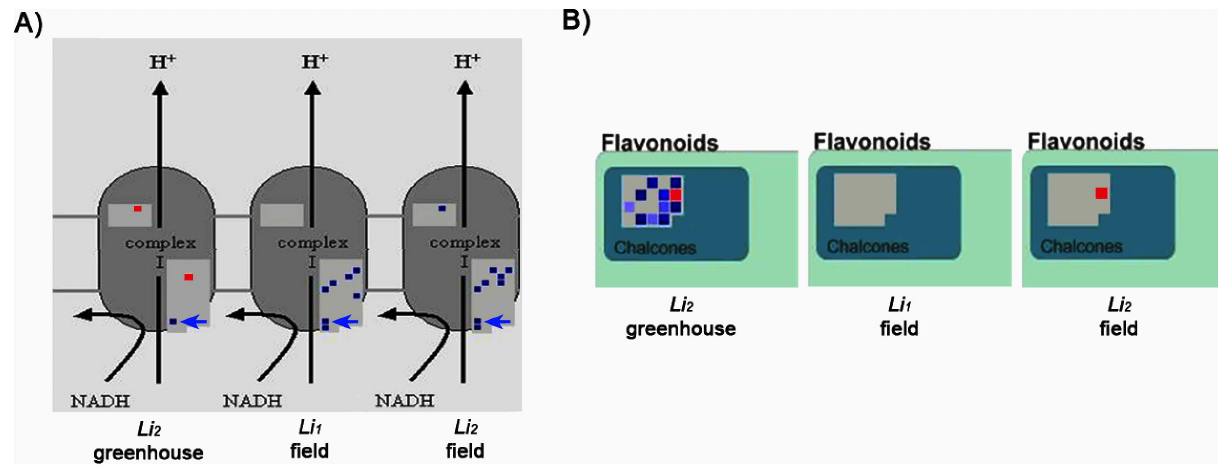
Figure 3. MapMan software illustrates different stress response of the short fiber mutants. Probes showing differential regulation were analyzed by MapMan software. The identification of processes affected differently in the wildtype and mutant lines was done manually. A) The Li 1 and Li 2 mutants showed increased (blue) expression of NADH dehydrogenase in field conditions as compared with greenhouse. Blue arrow indicating the common probe GhiAffix45916.1. B) Li 2 in greenhouse conditions exhibited increase chalcone synthase-related expression, which were not replicated in field conditions.